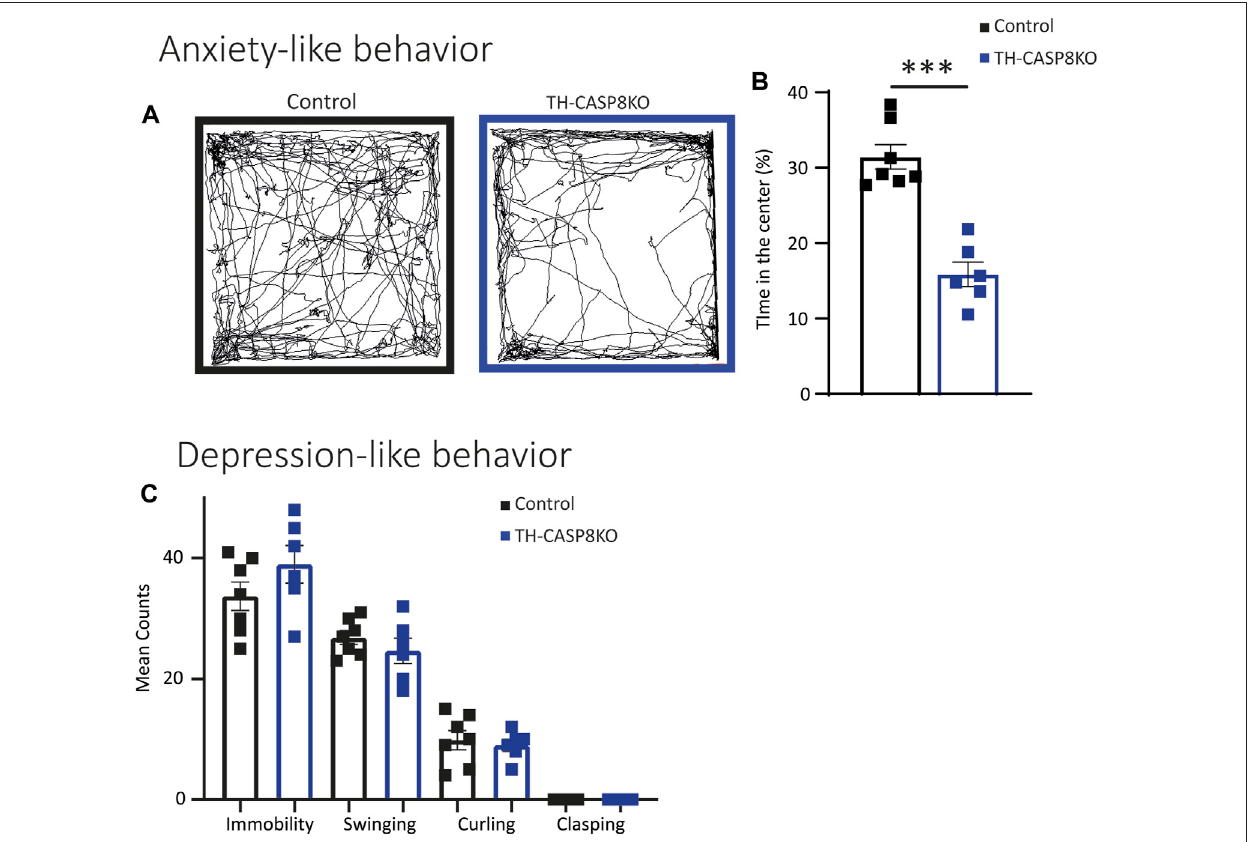
FIGURE 6 | TH-CASP8KO mice exhibit anxiety-like behavior but not depressive-like behavior. (A – B) TH-CASP8KO spend more time in the open fi eld periphery than in the center. (A) Representative traces of the open fi eld activity and (B) quanti fi cation, expressed as a percentage of time spent in the center (B) . TH-CASP8KO mice show immobility, clasping, swinging, and curling similar to control mice in tail suspension test (C) . Data are expressed as mean ± SEM of n = 6 – 7 mice/group. The two-tailed unpaired t test was used.*** p < 0.001 versus control mice.